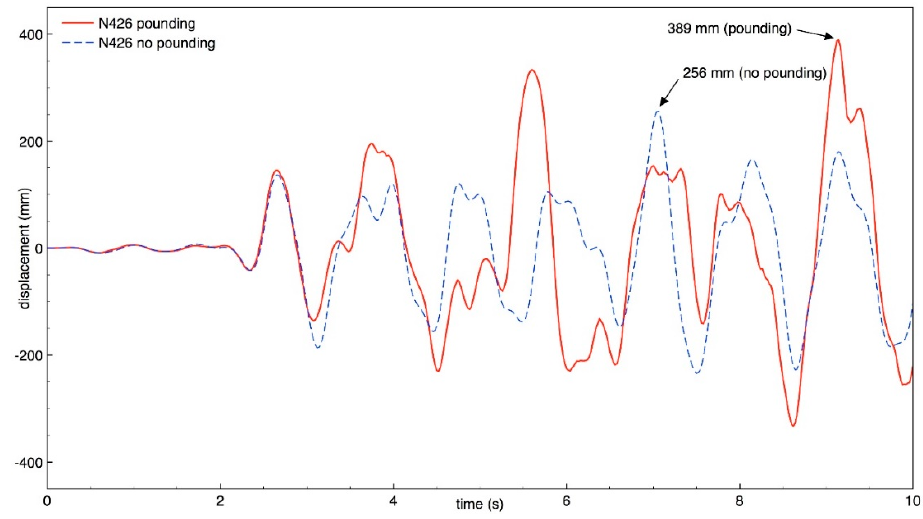
Figure 24. Transverse response of building B (node N426) with and without pounding.